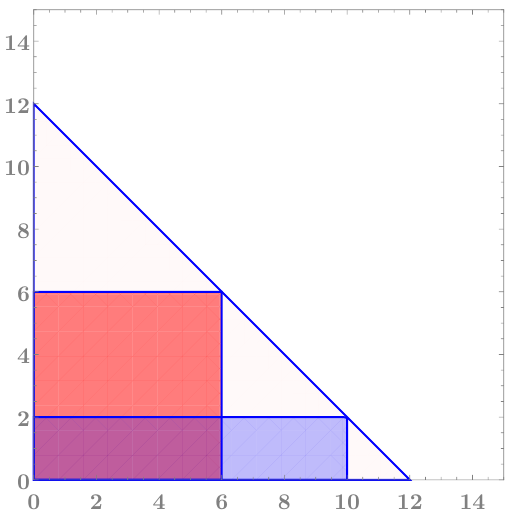
Figure 2 . ( h 0 ; (cid:22) h 0 ) plane: asymptotically, the rectangular region (blue shaded) contains exponen- tially less number of operators compared to square region (red shaded). They are contained within the rightangled triangle, created by h 0 axis, (cid:22) h 0 axis and h 0 + (cid:22) h 0 = (cid:1) line. Here (cid:1) = 12.